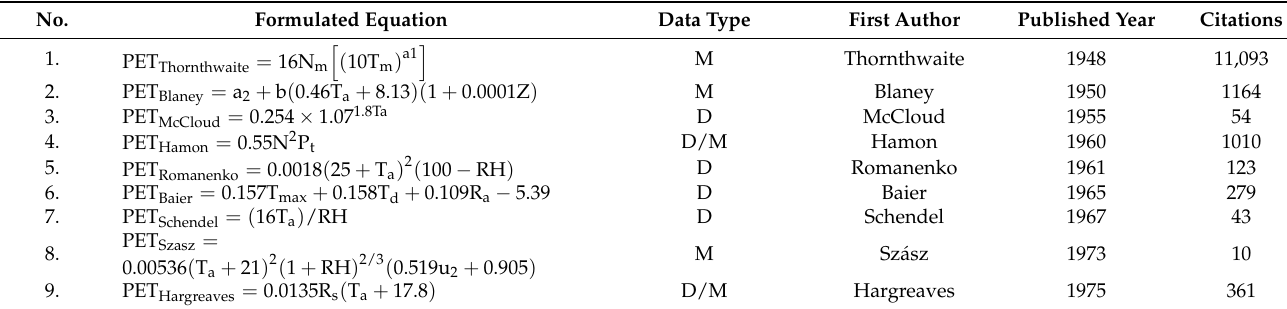
Table A1. PET temperature-based